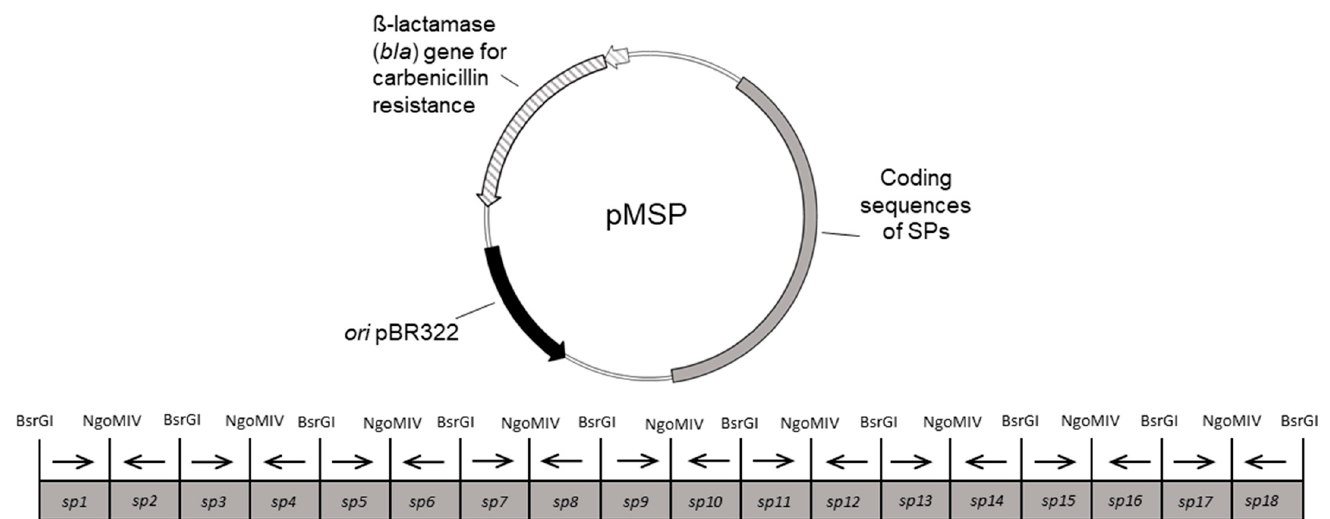
Figure 2. Map of a multi-signal peptide plasmid (pMSP). All pMSPs carry a resistance gene ( bla ) for carbenicillin resistance (striped), the ori of pBR322 for E. coli (black) and a DNA cassette encoding the individual SPs (gray). This DNA cassette is shown in more detail in the image below. It contains coding sequences of 18–20 SPs from P. megaterium DSM 319 flanked by BsrGI (upstream) and NgoMIV (downstream) recognition sites. The black arrows indicate the respective orientation of coding sequences of the SPs.